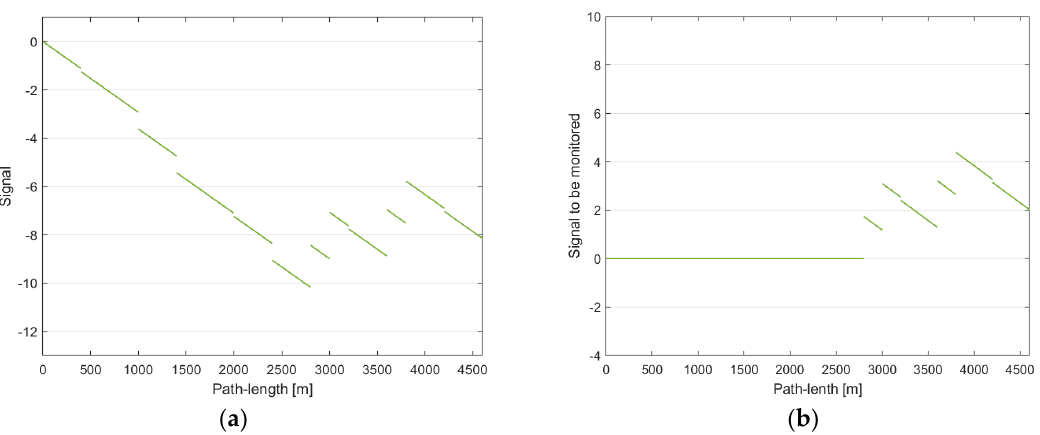
Figure 2. A Res → Dt change detector applied to a homologous RET transition appearing in the TS sequence given in the top band of Table 2: ( a ) Function g Res → Dt